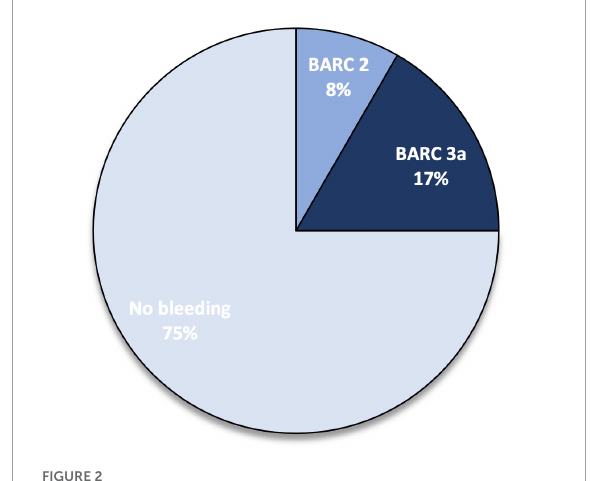
FIGURE2 Percentage of bleeding events at follow-up. BARC, Bleeding Academic Research Consortium.